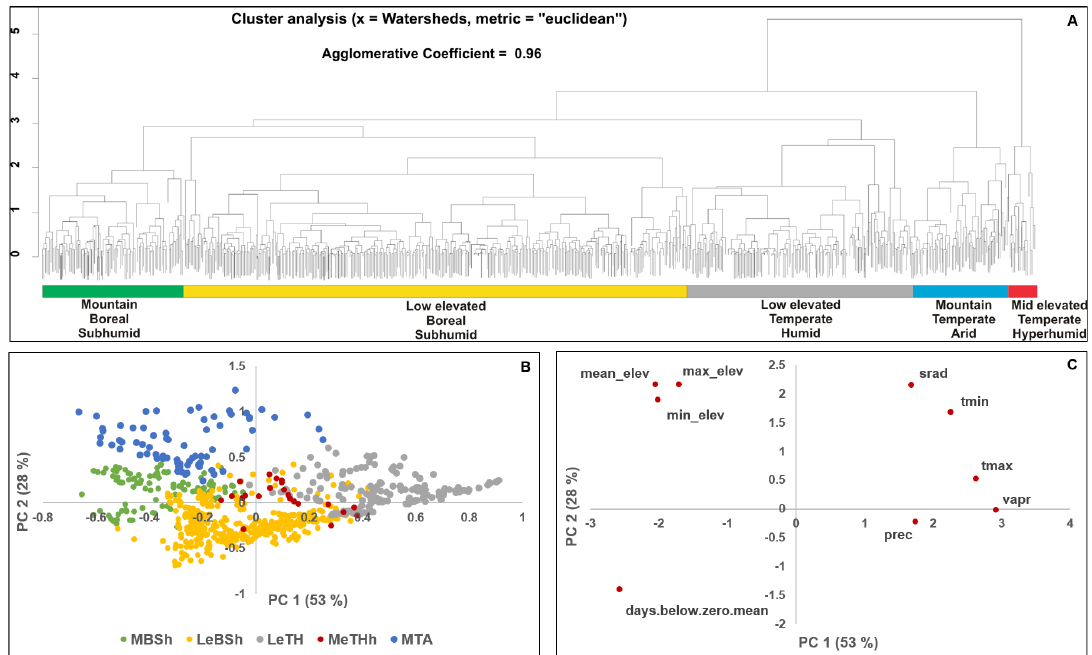
Figure 3. Results of the combined approach of cluster analysis using Principal Component Analysis PCA site scores as inputs ( A ), and PCA ordination with the analyzed environmental variables ( B , C ). ( B ) watershed scores labeled by regions. ( C ) factor scores of the environmental variables. Environmental regions: Mountain Boreal Sub-humid (MBSh); Low elevation Boreal Sub-humid (LeBSh); Low elevation Temperate Humid (LeTH); Mountain Temperate Arid (MTA); Mid-elevation Temperate Hyper-humid (MeTHh). Environmental variables: mean_elev, max_elev, min_elev (mean, maximum, and minimum elevation); srad (solar radiation); tmin, tmax (minimum and maximum annual temperature); vapr (vapor pressure); prec (precipitation); days.below.zero.mean (annual mean days with below zero temperatures).